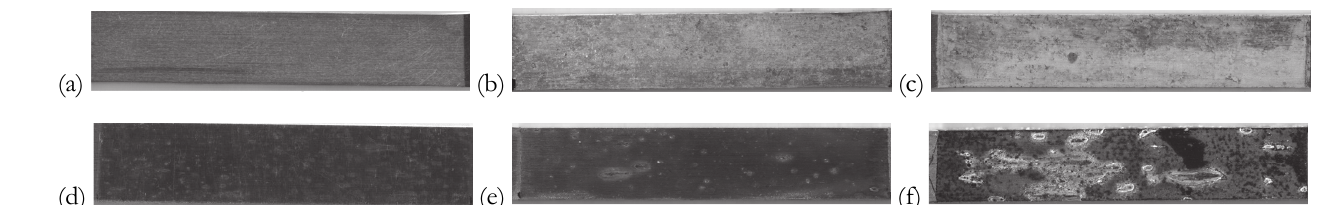
Figure 2: Typical photographs of AA2024-T3 pre-corroded tensile specimens exposed to the EXCO solution for (a)-(c) 2 h, 4 h and 24 h of EXCO solution and (d) – (f) 6 h, 168 h and 720 h of 3.5 wt. % NaCl solution,